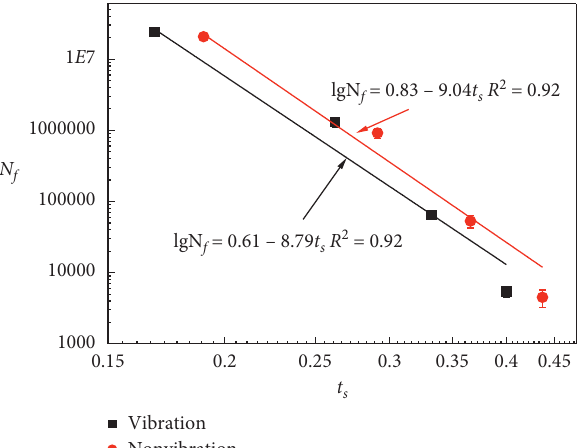
Figure 12: Unconfined compressive fatigue curve based on real stress ratio of specimens prepared with different mixing